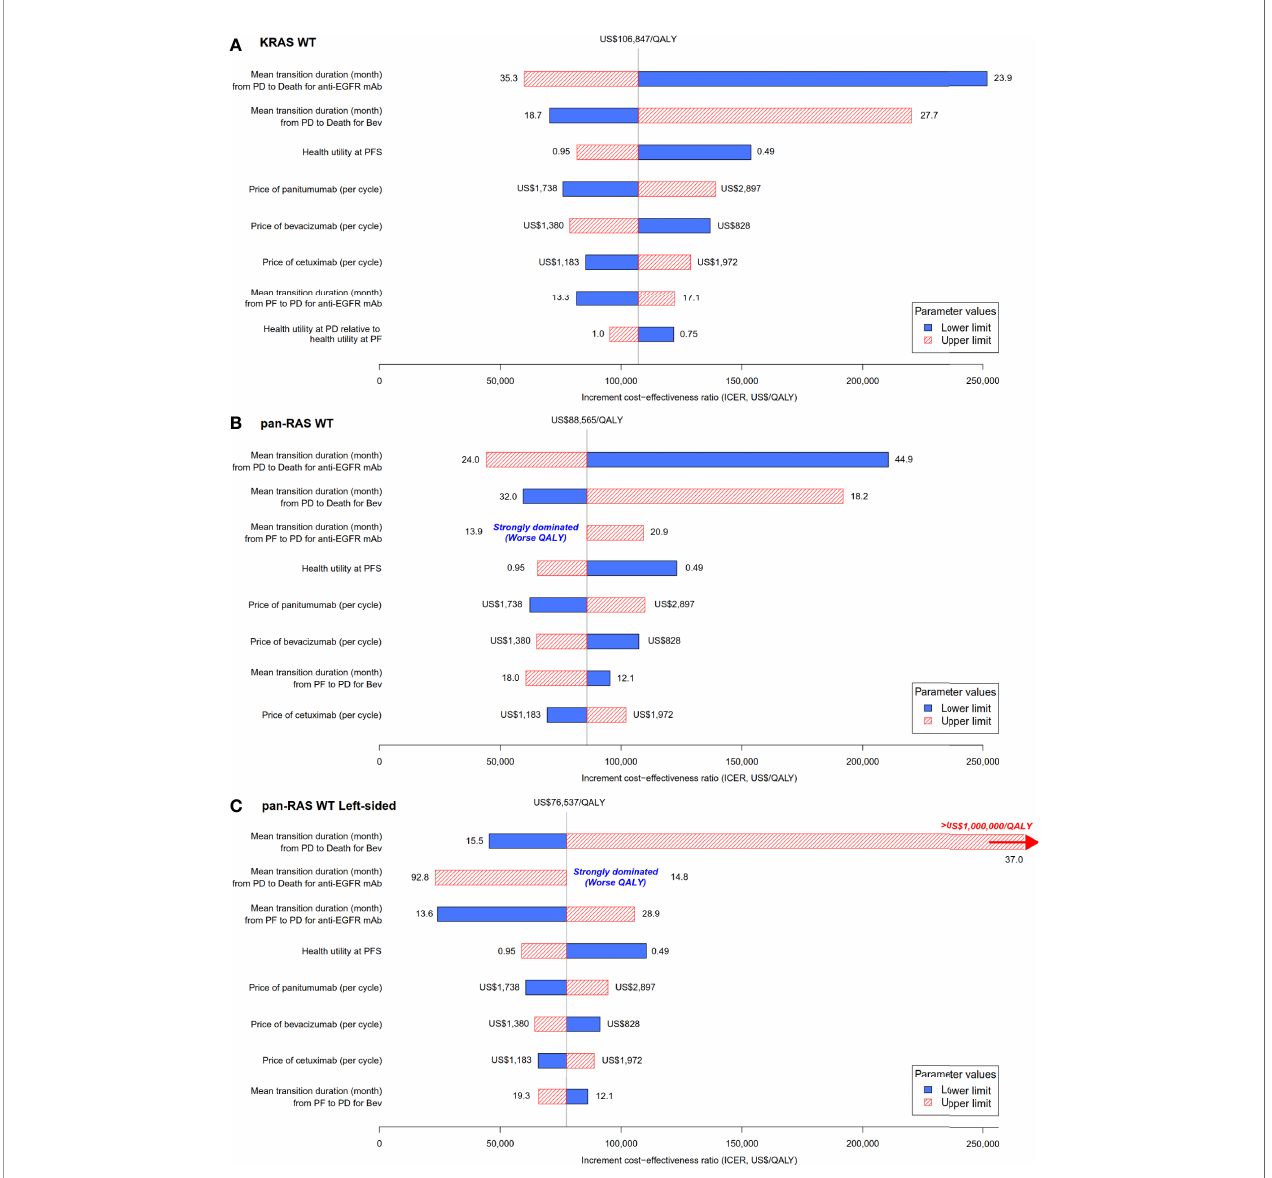
FIGURE 3 | Tornado plot for the one-way univariable sensitivity analyses: chemotherapy + anti-EGFR mAb vs. chemotherapy + bevacizumab in (A) KRAS WT, (B) pan-RAS WT, and (C) pan-RAS WT left-sided colonic tumor. anti-EGFR mAb, anti-epidermal growth factor receptor monoclonal antibody; PD, progressive disease health state; PF, progression-free health state; PFS; progression-free survival; QALY, quality-adjusted life years; WT,